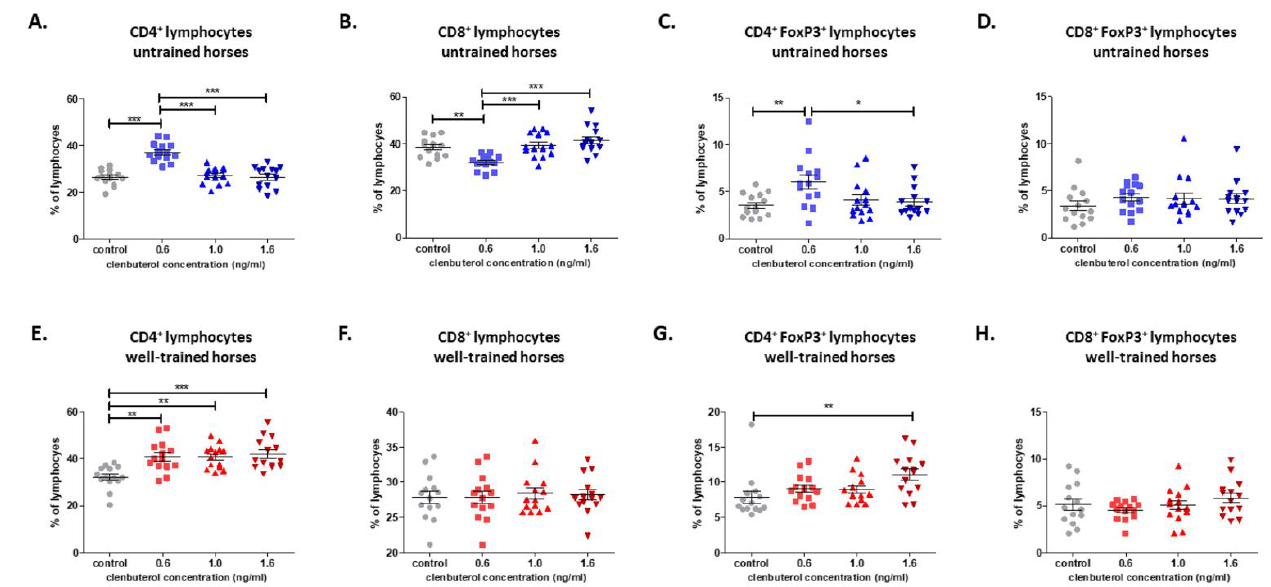
Figure 2. Graphic representation showing percentages of positive cells: CD4+ ( A , E ), CD8+ ( B , F ), CD4+FoxP3+ ( C , G ), and CD8+FoxP3+ ( H , D ) gated from total lymphocytes. Each dot represents one individual horse ( n = 28) and means ± SEM (standard error of the mean) are presented. The significance levels are: * p < 0.05; ** p < 0.01, and *** p < 0.001.